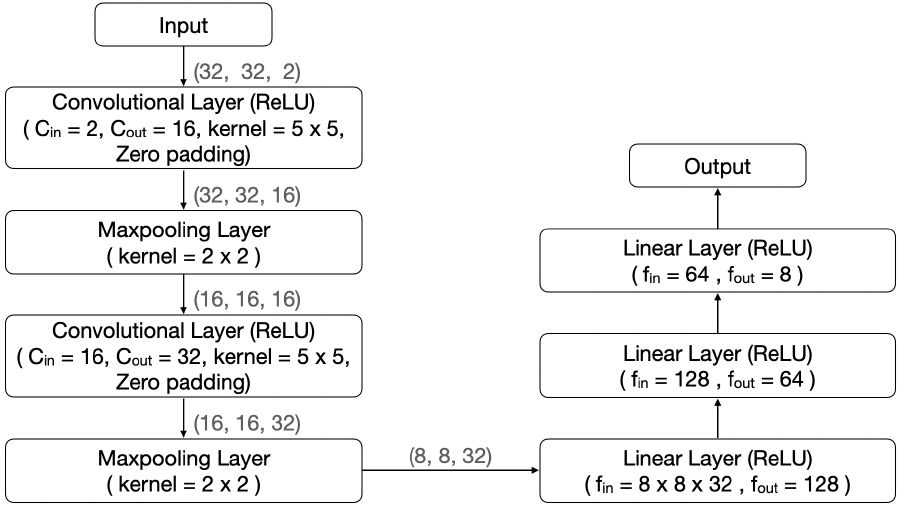
Figure 9. The structure of